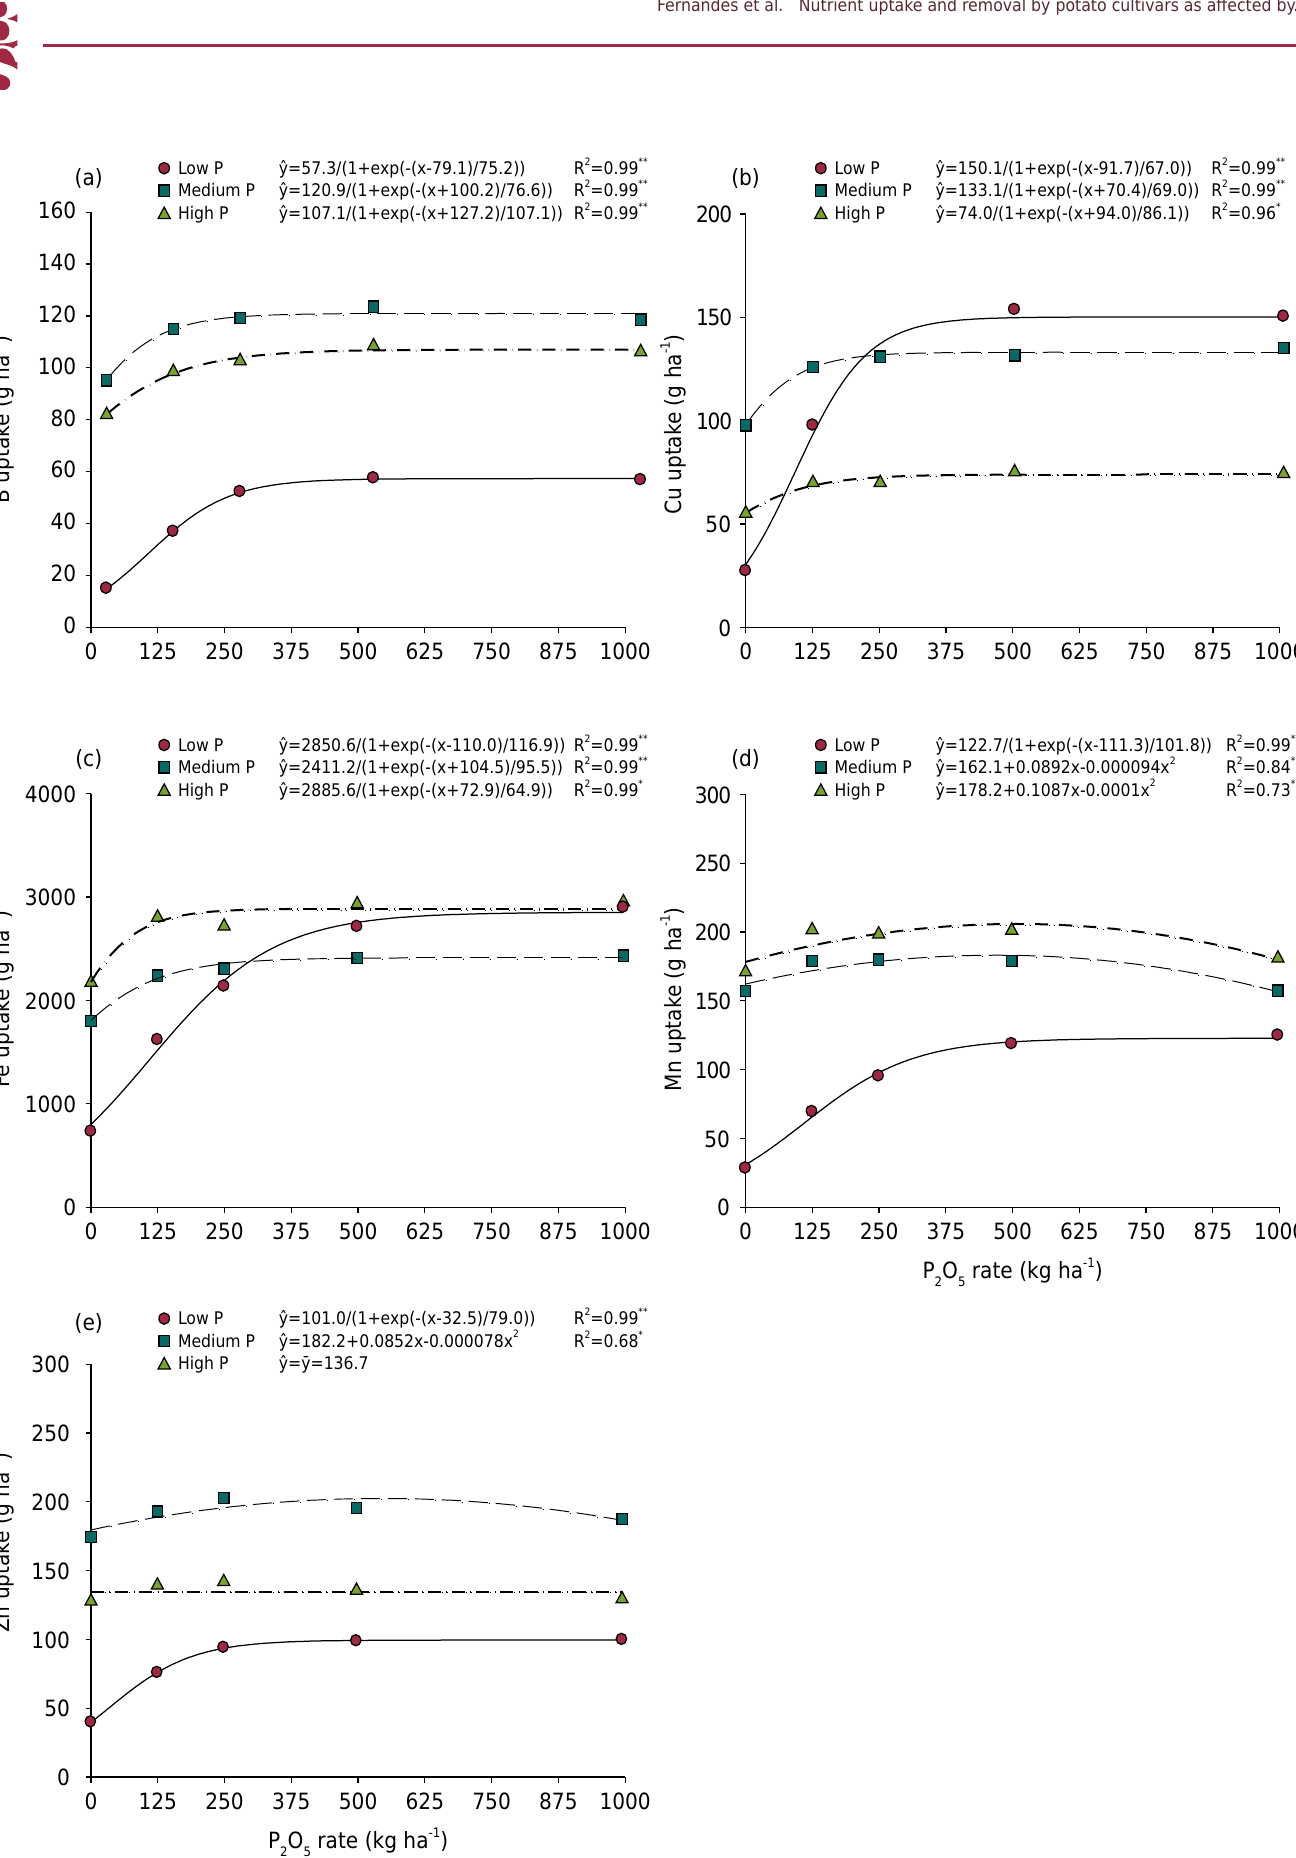
Figure 4. Uptake of B (a), Cu (b), Fe (c), Mn (d), and Zn (e) by potato plants as affected by rates of P applied in the planting furrow in soils with low, medium, and high P availability. Means of five cultivars. * and ** : significant at 5 and 1 % by the F